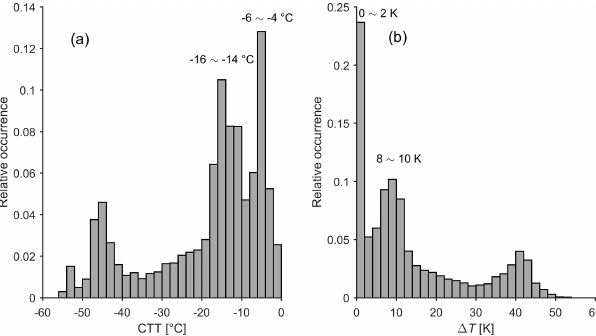
Figure 6. Relative occurrence of (a) CTT and (b) (cid:49)T for columnar- ice production cases. (cid:49)T = T column_top − CTT.